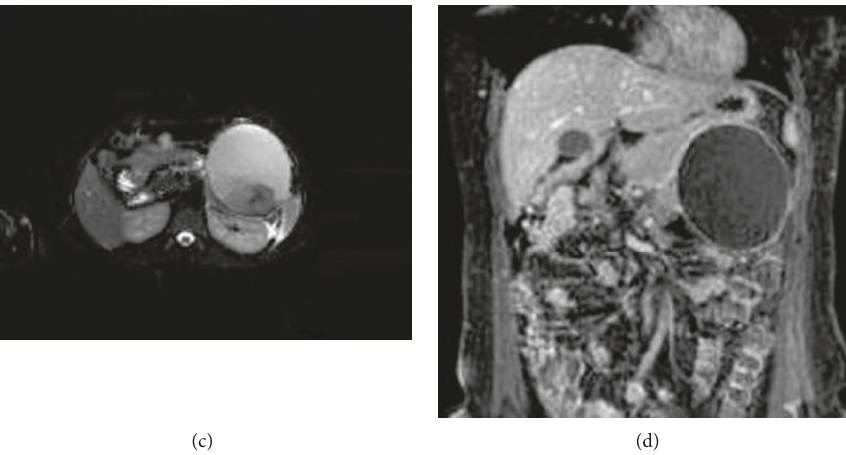
Figure 1: (a) Colour Doppler ultrasound image showing a cystic lesion containing echogenic debris with no vascularity. (b) Sagittal contrast-enhanced CTimage showing the cystic lesion located within the left kidney and the tail of the pancreas. (c) Axial T2-weighted MR image with fat suppression confirming the cystic nature of the lesion. Note: it is made of dependent low-signal intensity debris, in keeping with hemorrhagic content. (d) Coronal contrast-enhanced T1-weighted MR image showing only mild capsular enhancement but no enhancement within the